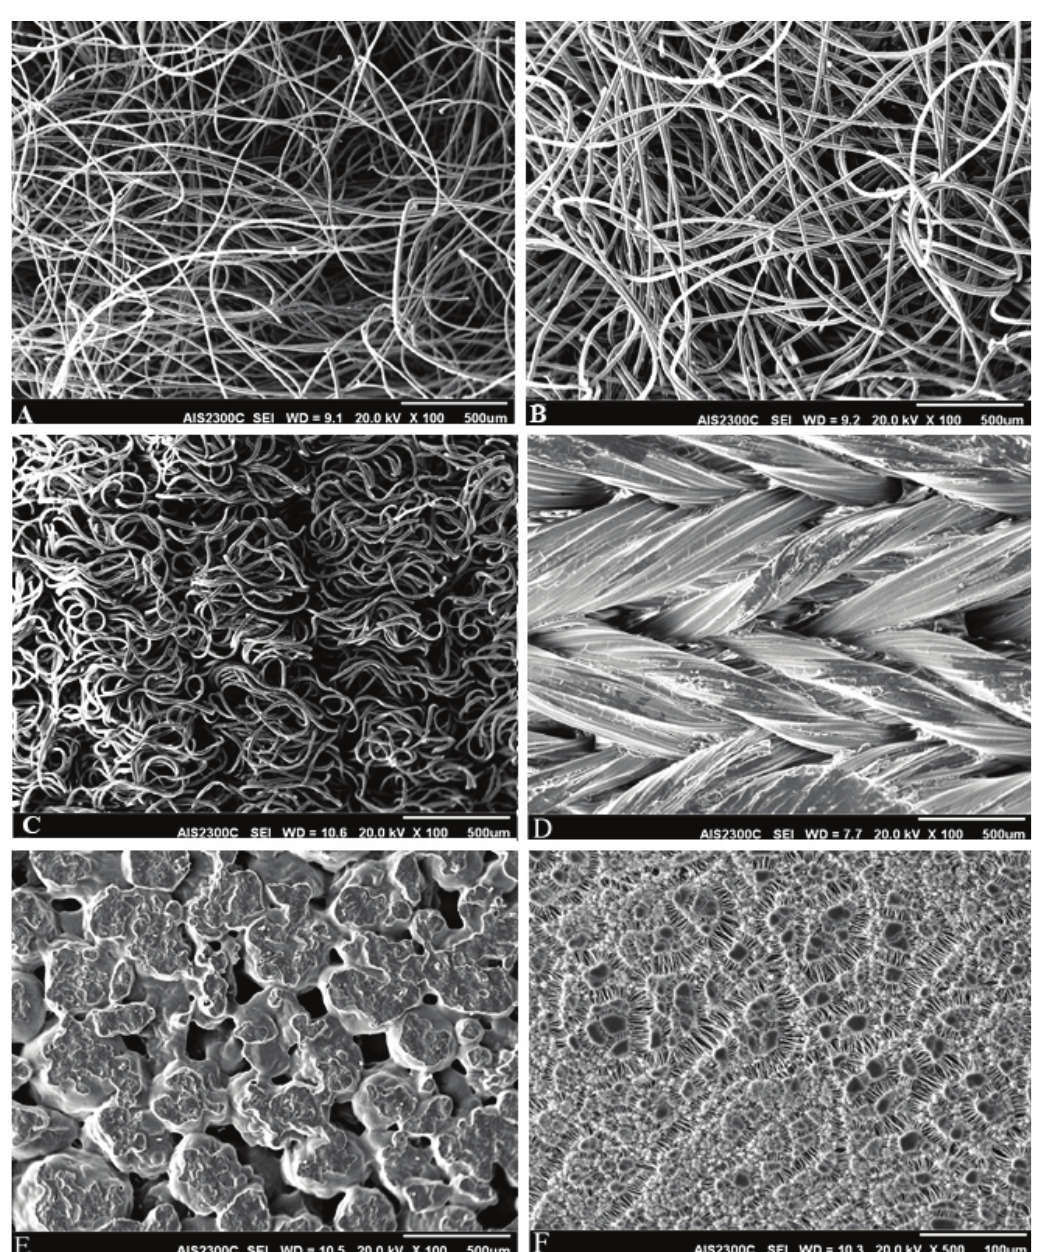
Figure 1. Scanning electron microscopy of examined polymers. (A & B) anisotropic medium composed of randomly dispersed filaments; (C) a number of single fibers compacted with each other in an almost vertical status; (D) woven fascicles of polytetrafluoroethylene consisting of fine microfilaments and disperse coating on PTFE woven fabric so that the whole fiber surface is covered; (E) pores of different shapes and without uniform distribution; (F) open and straight porous structure with an almost uniform slit-like pores in the surface of the expanded polytetrafluoroethylene